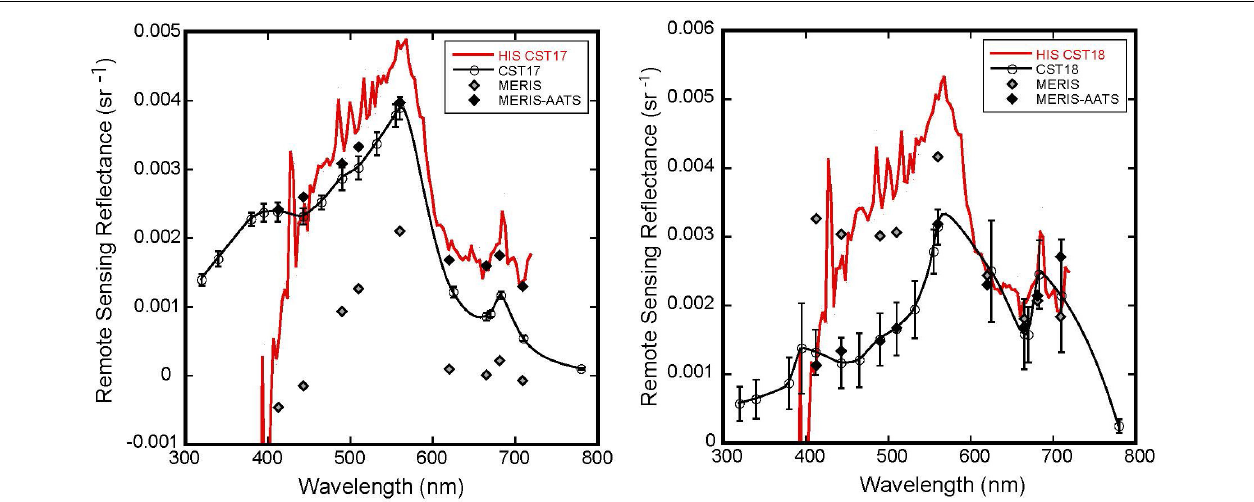
FIGURE 3 | Remote sensing reflectance ( R rs , sr - 1 ) is plotted for CST17 and CST18 stations, for the HIS (red line), C-OPS in-water profiler (open circles), and MERIS with standard atmospheric correction (open diamonds) and with AATS-14-derived atmospheric correction (solid diamonds). Error bars on the C-OPS data indicate one standard deviation from three consecutive